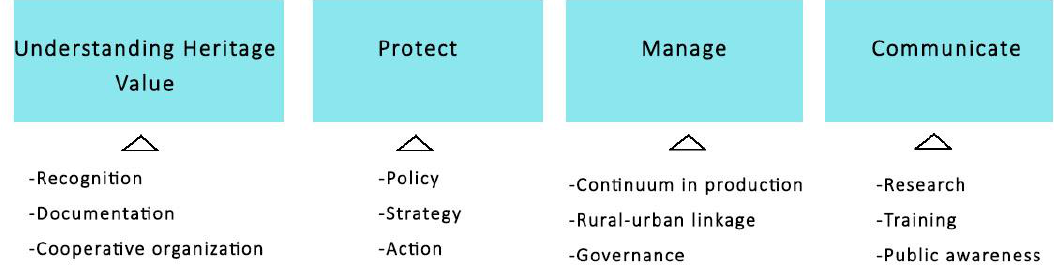
Figure 14 The operational action path for sustaining cultural landscapes (Adapted from ICOMOS,